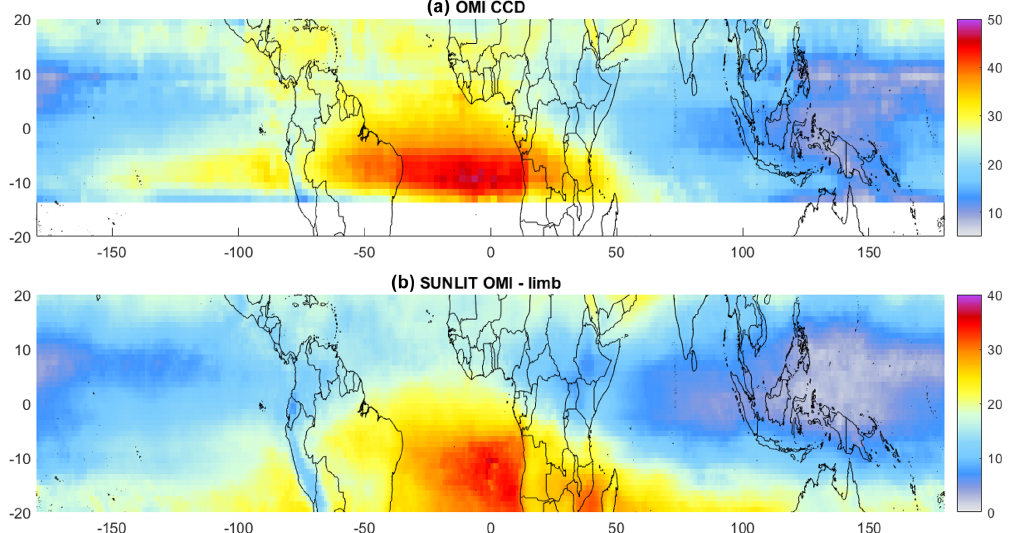
Figure 17. Tropospheric ozone column in DU (color) for September 2008 from (a) OMI CCD and (b) SUNLIT data (SOC is integrated from